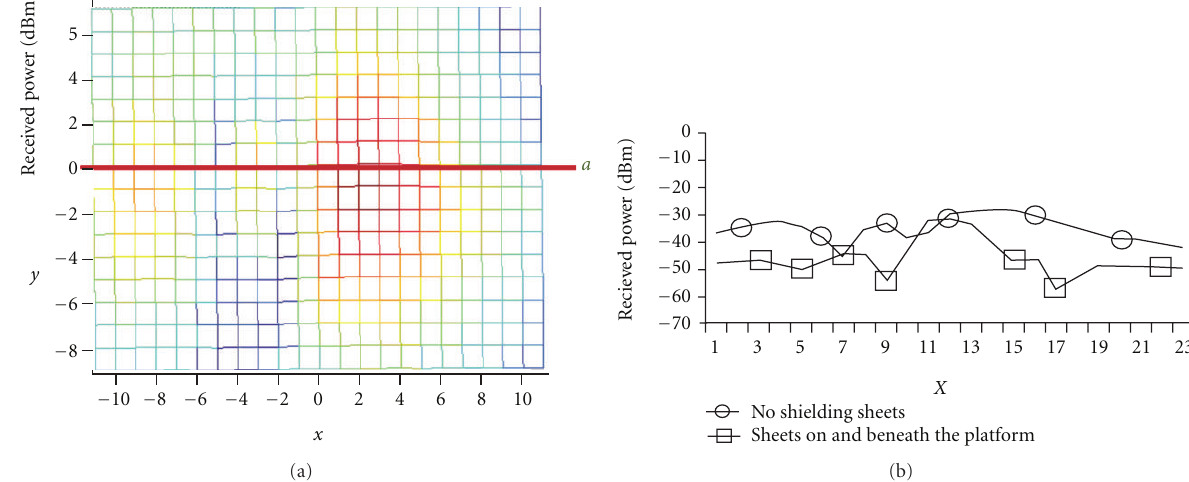
Figure 11: One-dimensional distribution of proximity field (a) line for measurement, (b) comparison with and without sheets on and beneath the